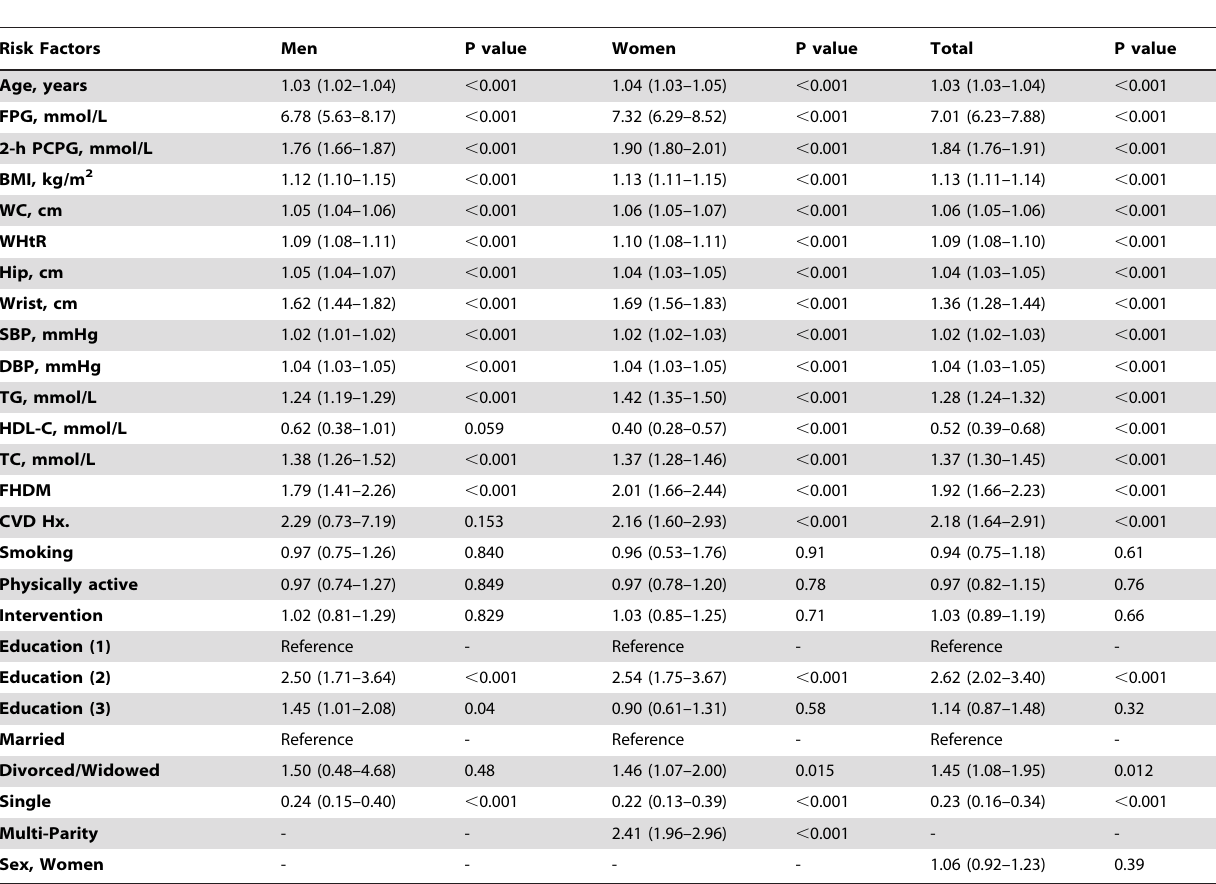
Table 3. Hazard Ratios (HR) and 95% Confidence Intervals (CI) from the Uni-variable Analysis of Potential Risk Factors in Relation to Diabetes Incidence by